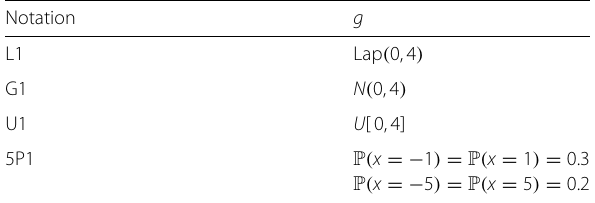
Table 2 Nonzero coefficients